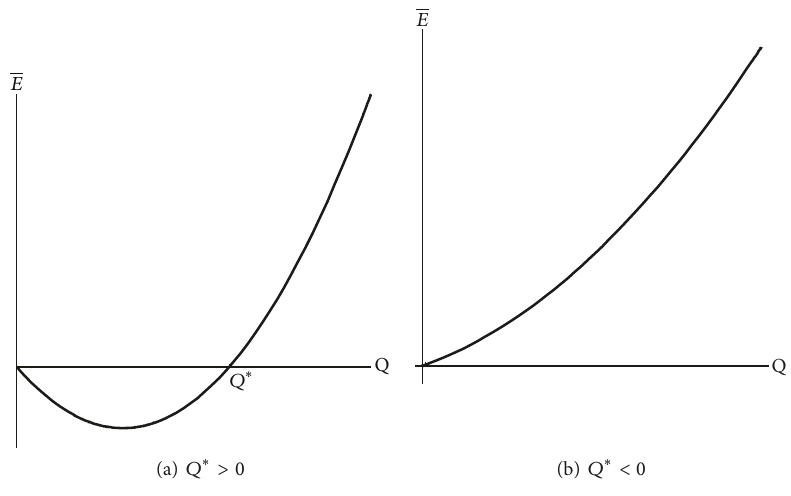
Figure 1: Relation of 𝑄 and 𝐸